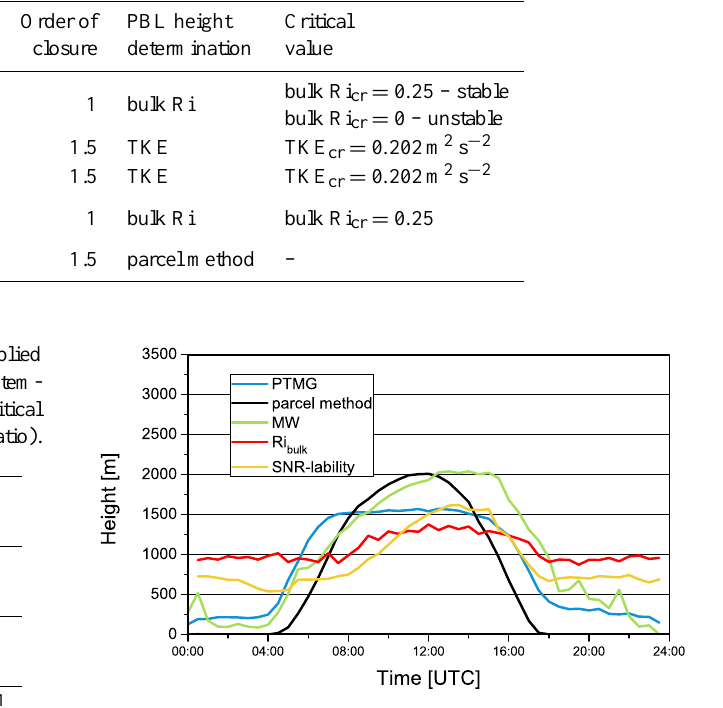
Figure 2. Average (July–September, 2012) diurnal course of PBL height derived from wind-profiler and radiometer measurements.